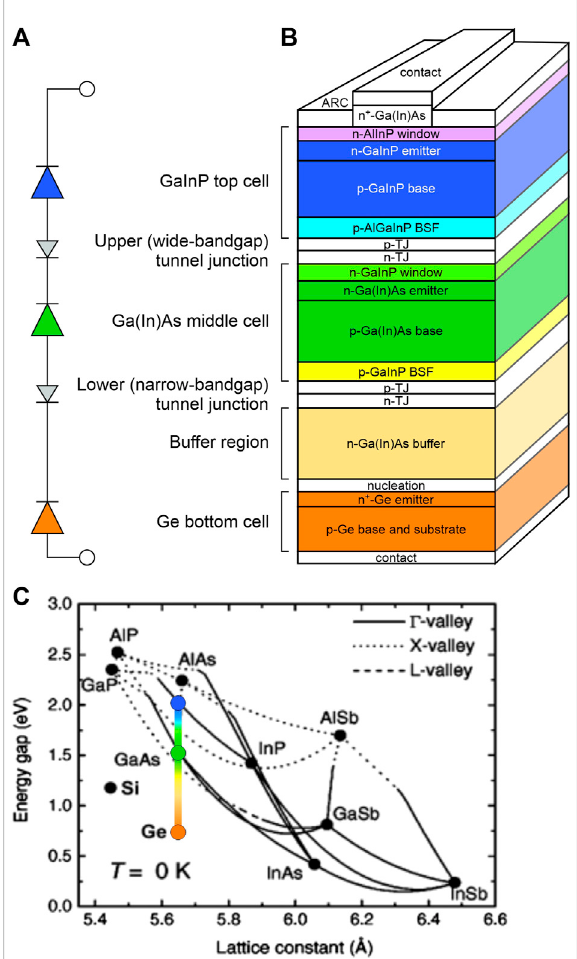
FIGURE 1 Equivalent electric circuit (A) and schematics (B) of a typical triple junction (3-J) solar cell. (C) Energy bandgaps vs. lattice constants for III-V semiconductors. Lattice-matched materials, usedfor3-Jsolarcells,appearasaverticalline(highlightedin color). Images adapted from (Cotal et al.,